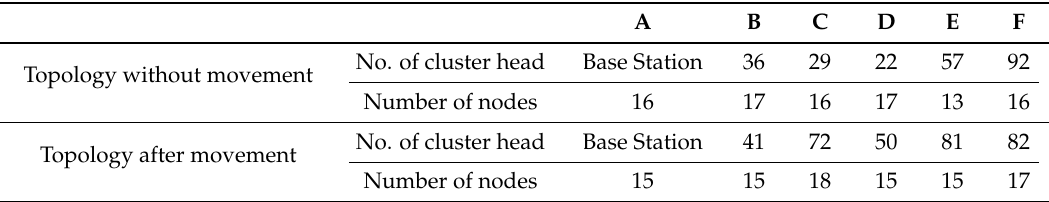
Table 1. The topology change result after the movement of the nodes.